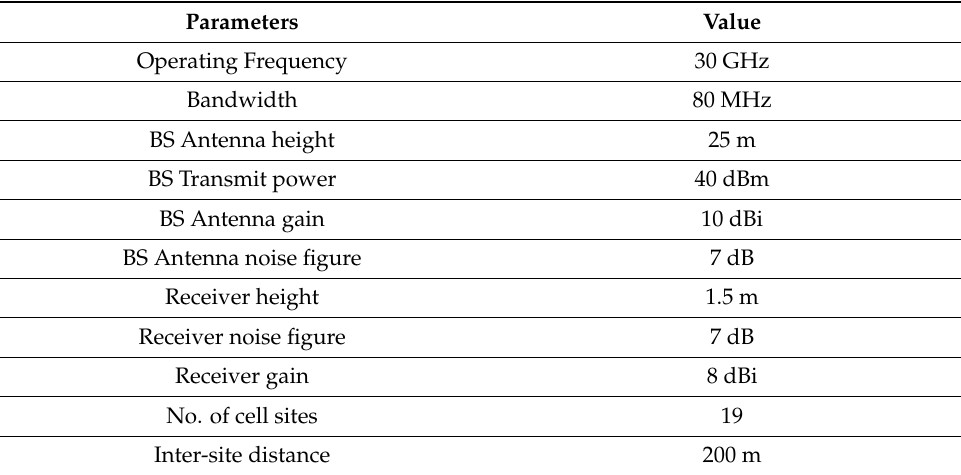
Figure 17. 5G Network Coverage and SINR Map for 8-by-8 Antenna Array. Table 2. Simulation parameters for 5G network coverage and